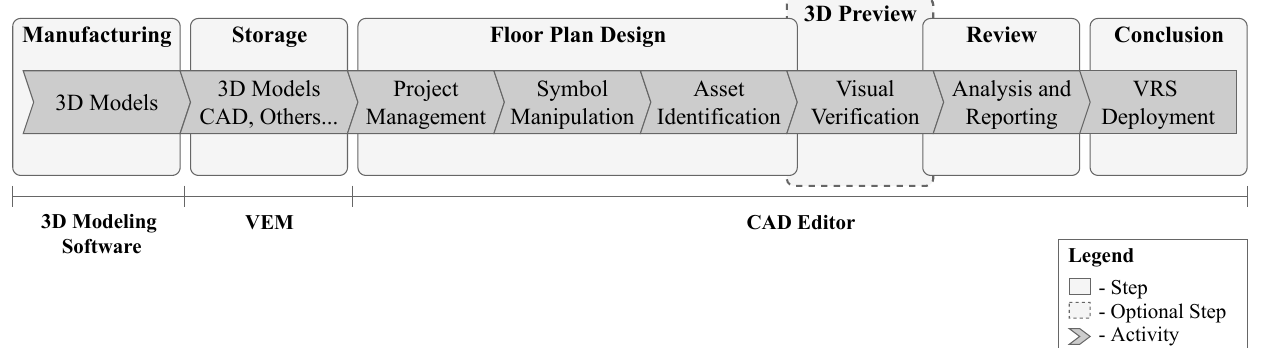
Figure 3. Production stages of VEs to Virtual Reality using the Authoring